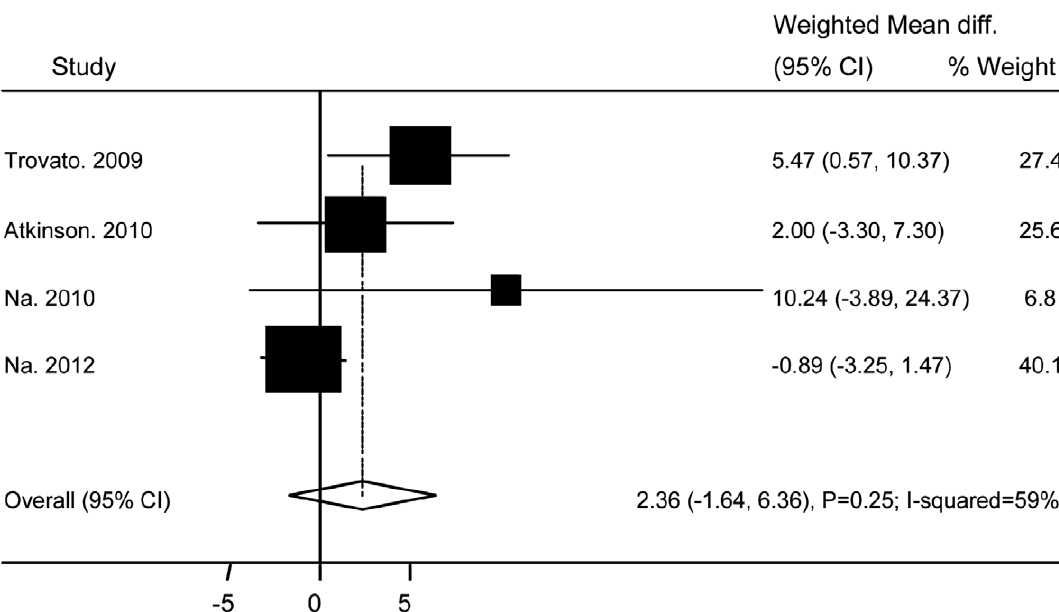
Figure 9. Association of Ad36 with Systolic Blood Pressure.